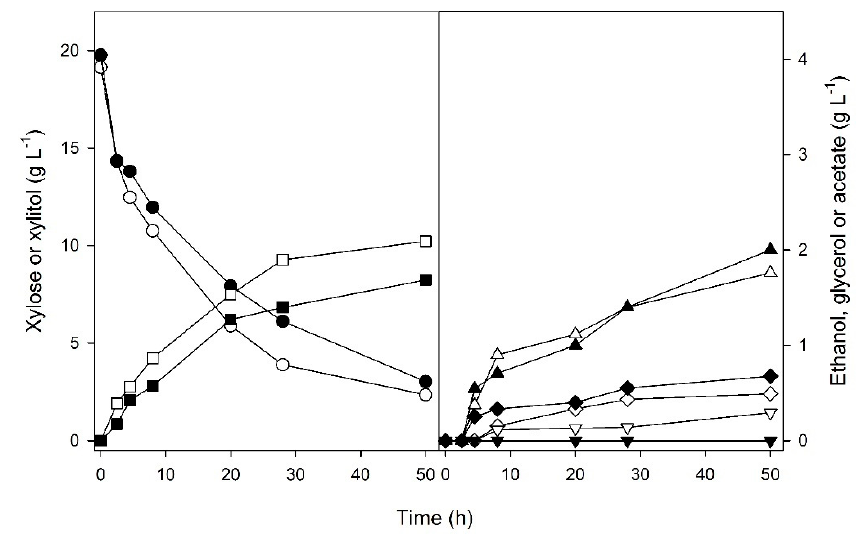
Figure 2. Time course of xylose consumption (circles), and xylitol (squares), ethanol (triangles), glycerol (diamonds), or acetate (inverted triangles) production during 2% xylose batch fermentations in YNB medium by yeast cells of strain ASY-2 transformed with plasmids pPGK- SaXYL1 and pTEF- SpXYL2.2 (white symbols), or plasmids pGPD- SaXYL1 and pPGK- SpXYL2.2 (black symbols).